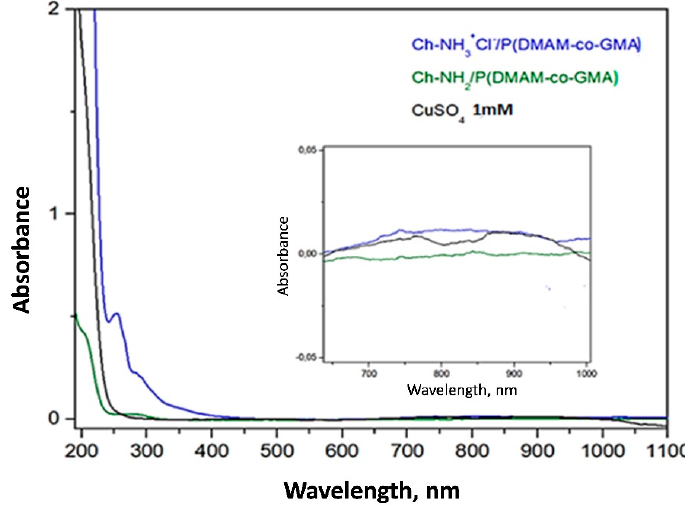
Figure 7. UV-vis spectrum of aqueous CuSO 4 1 mM solution before and after immersion of the membranes Ch-NH 3 + Cl − /P(DMAM-co-GMA 30 ) 8:2 and Ch-NH 2 /P(DMAM-co-GMA) 8:2 for 24 h.